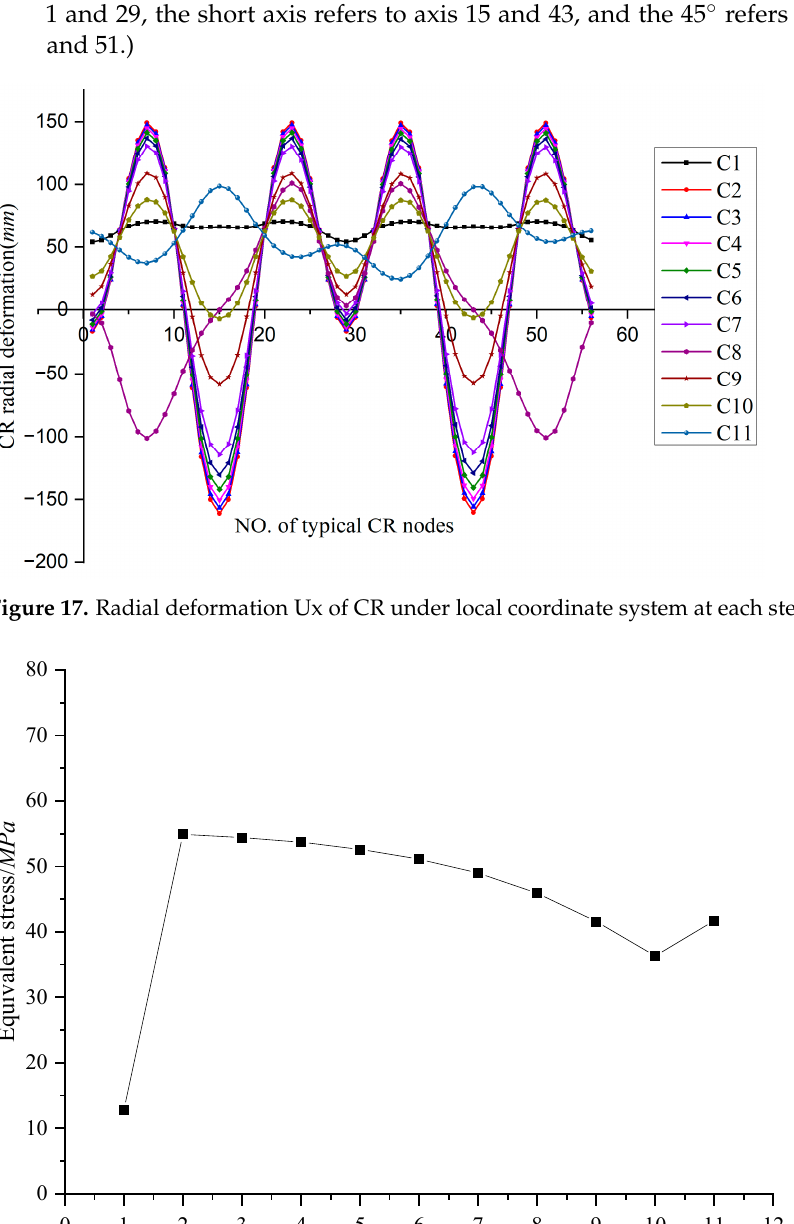
Figure 18. Maximum equivalent stress curve of CR.